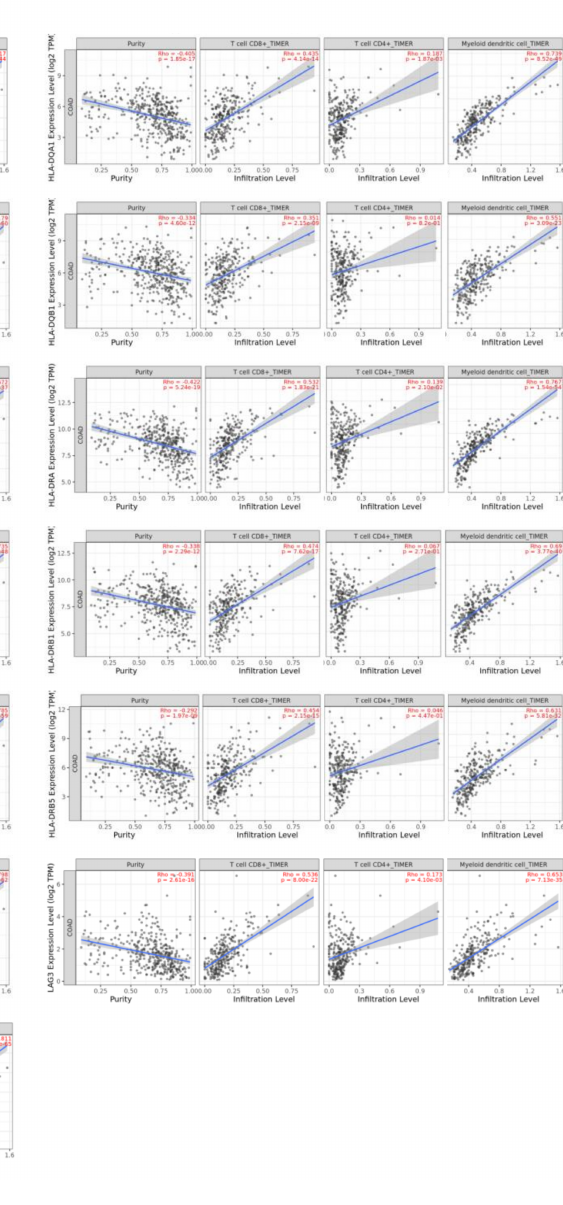
Figure 3. Association between the immune surfaceome related genes’ expression and the immune cell population tumor infiltrate. Dot plot showing the expression in COAD (n = 458) of upregulated genes ( CD74 , FCGR2B , HLA-DMA , HLA-DMB , HLA-DOA , HLA-DPA1 , HLA-DPB1 , HLA-DQA1 , HLA-DQB1 , HLA-DRA , HLA-DRB1 , HLA-DRB5 , and LAG3 ) in the Y axes and the infiltration level of some immune cells (CD8+ T, CD4+ T, and myeloids’ dendritic cells) in the X axes. The blue regression line shows the positive correlation and Rho and Spearman’s p -value data are presented in